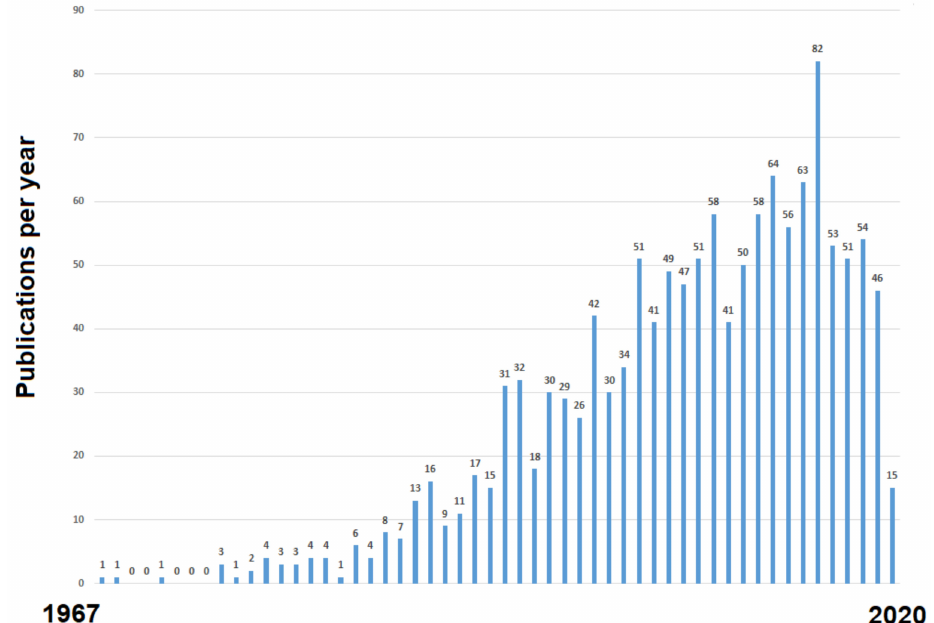
Figure 1. Evolution of publications per year as shown by a PubMed search on 29 October 2020 for the terms colorectal neoplasms [MESH] AND drug therapy [MESH] AND “adjuvant” and the filter “clinical trials”. [MESH] refers to the search tag used to indicate “medical subject